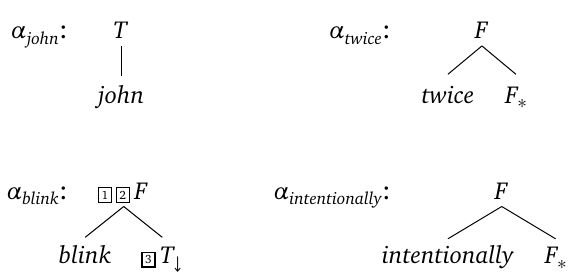
Figure 9: A fragment with multiple